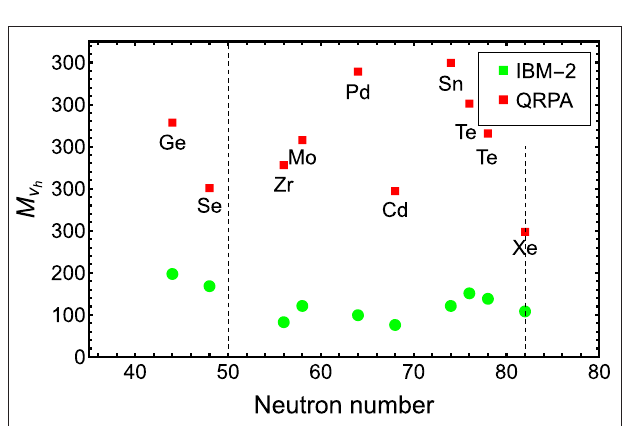
FIGURE 2 | Total heavy neutrino exchange 0 ν h ββ nuclear matrix elements M ν obtained with interacting boson model (IBM-2) and quasiparticle random h phase approximation (QRPA) using same form factor charges, same overall sign for tensor matrix elements, and the convention that M ν